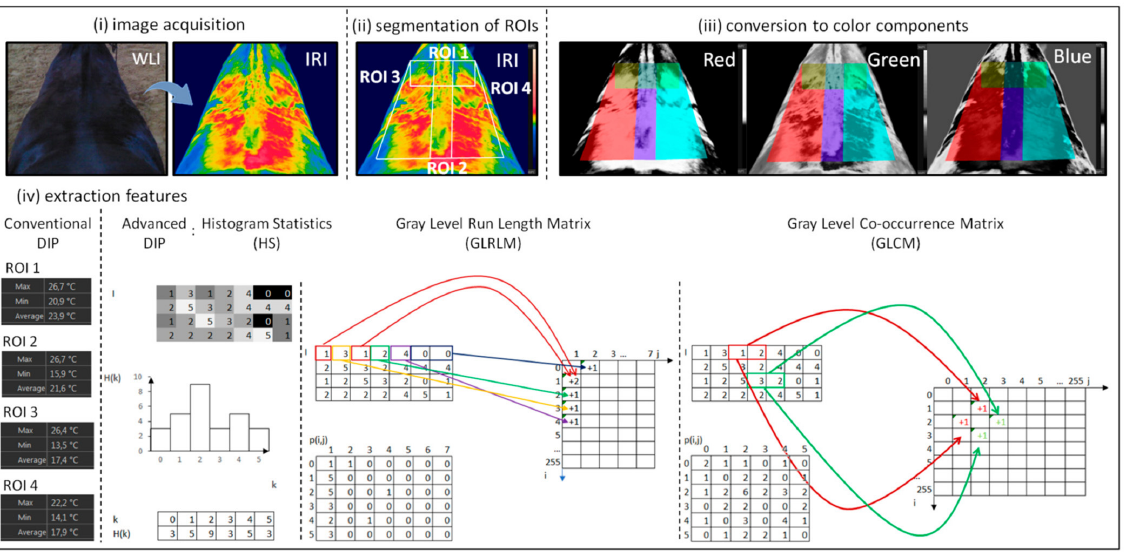
Figure 1. The thermal image processing steps included: ( i ) image acquisition, ( ii ) segmentation of ROIs, ( iii ) conversion to color components, and ( iv ) extraction features for both conventional and advanced digital image processing. WLI—white light; IRT—infrared thermal image; ROI—region of interest; DIP—digital image processing; Min—the minimal temperature; Max—the maximal temperature; Average—the average temperature; HS—histogram statistics and the example of image with its histogram; GLRLM—gray-level run-length matrix with the example of horizontal matrix; GLCM—gray level co-occurrence matrix with the example of matrix for a 1-pixel distance in the horizontal